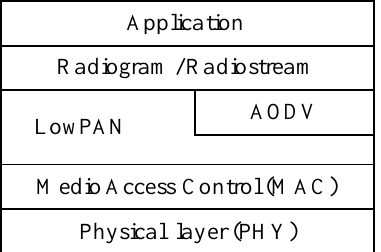
Figure 4. Sun SPOT network